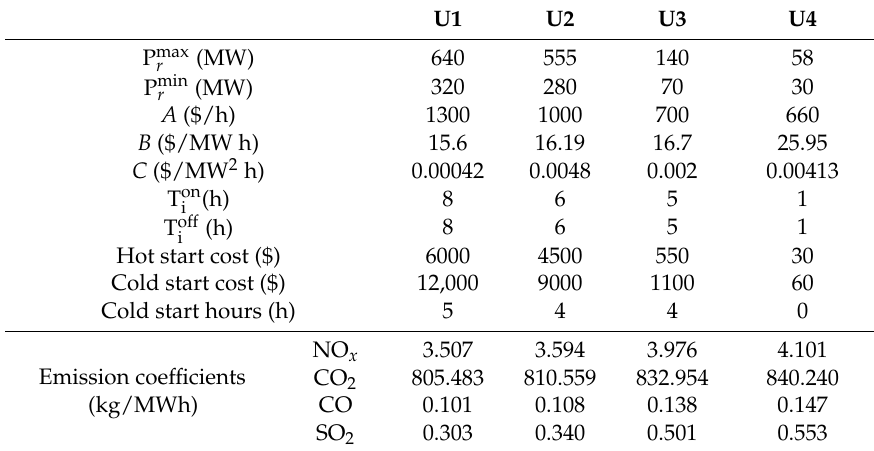
Table 1. Parameters of thermal generating units (TGUs).